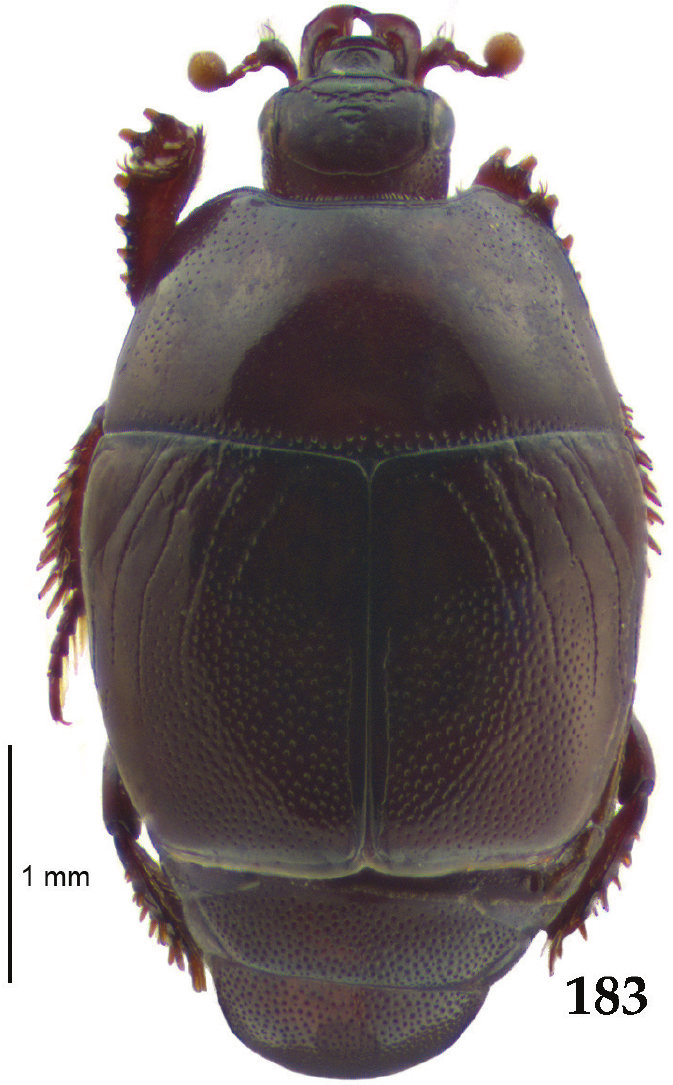
Figure 183. Hypocaccus ( Baeckmanniolus ) varians varians (Schmidt, 1890) habitus, dorsal view. “Saprinus varians / Schmidt, 1890 / LECTOTYPE 2014 / des. Lackner & Leschen” (red label, written) (ZMHUB). Paralectotypes, present designation: 4 specs., probably ♀♀ , carrying the same hand-written labels “Japan” and “Type” and the printed label “Saprinus / varians Schmidt / Coll. Schmidt-Bickhardt”, followed by the paralectotype labels identical to that of the lectotype (ZMHUB). This species has been described from unknown number of specimens and the lectotype designation fixes the taxo- nomic identity of the